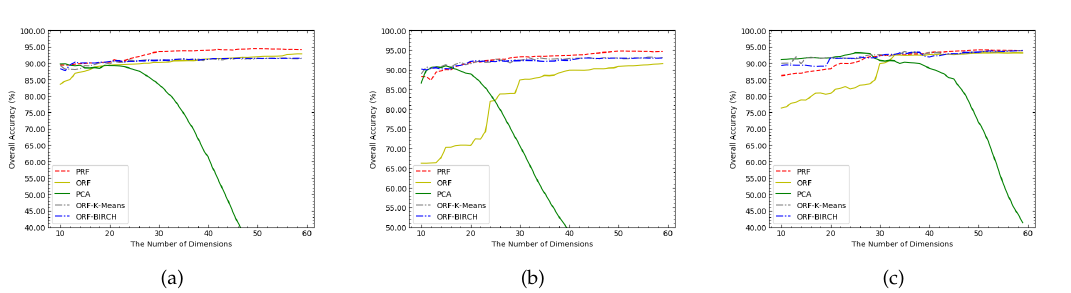
Figure 5. The classification overall accuracy (OA) changes under different dimensions of the subsets and different dimensionality reduction methods. The three data sets Salinas, PaviaU, and KSC are marked by ( a ), ( b ), and ( c ), respectively.